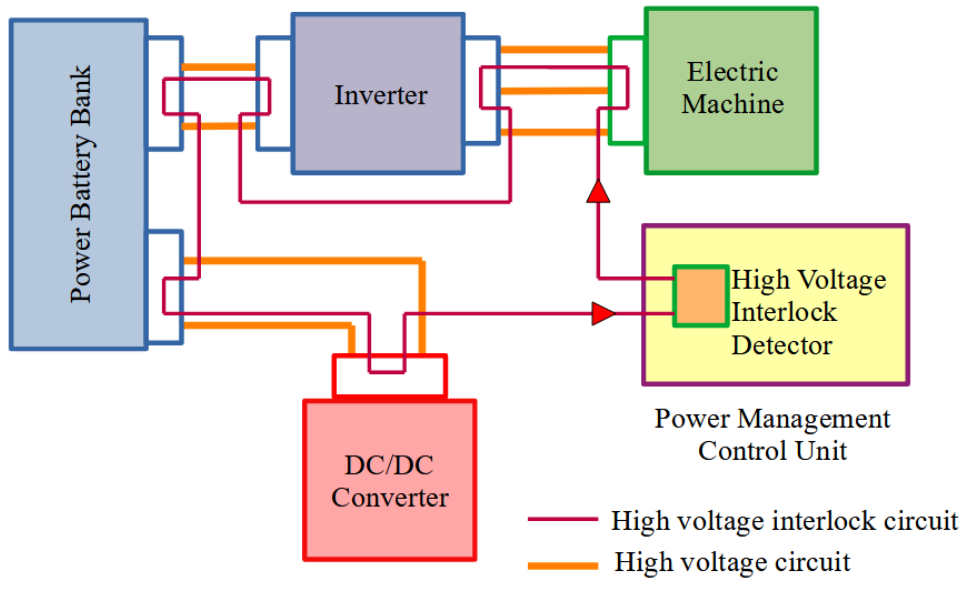
Figure 13. High Voltage Interlock Loop (HVIL).